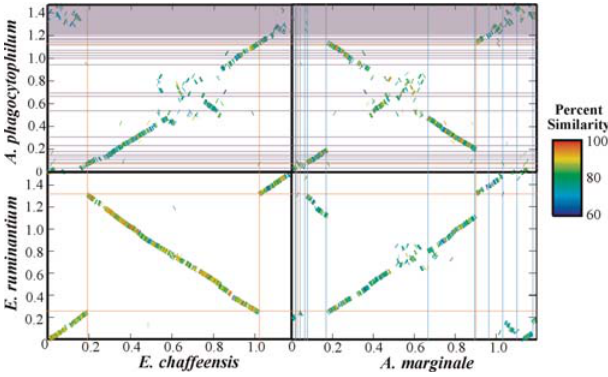
Figure 3. Synteny between Anaplasma spp. and Ehrlichia spp. Anaplasma spp. and Ehrlichia spp. share conserved gene order (synteny) across their chromosomes. E. ruminantium and E. chaffeensis have a single symmetrical inversion near two duplicate Rho termination factors (approximate positions shown in pink). Genomic rearrangements between these Rho termination factors are also apparent in A. marginale (pink). In addition to the synteny breaks near the Rho termination factors, A. marginale has rearrangements located near the msp2- and msp3- expression locus and pseudogenes (approximate positions shown in light blue). Likewise, in A. phagocytophilum, numerous changes in genome arrangement are located near the homologous p44 expression locus and silent genes (approximate positions shown in lavender). DOI: